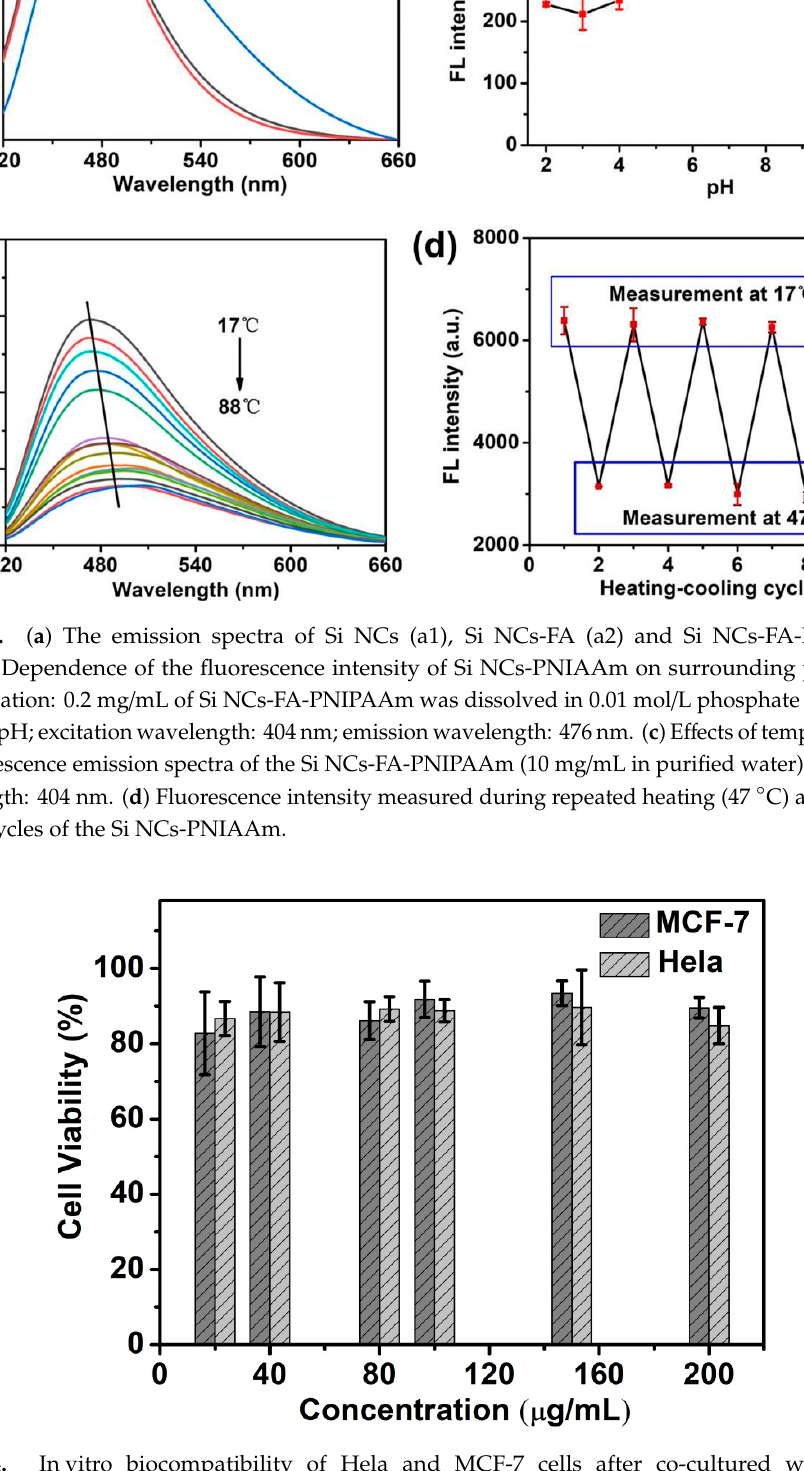
Figure 4. In vitro biocompatibility of Hela and MCF-7 cells after co-cultured with the Si NCs-FA-PNIPAAm for 24